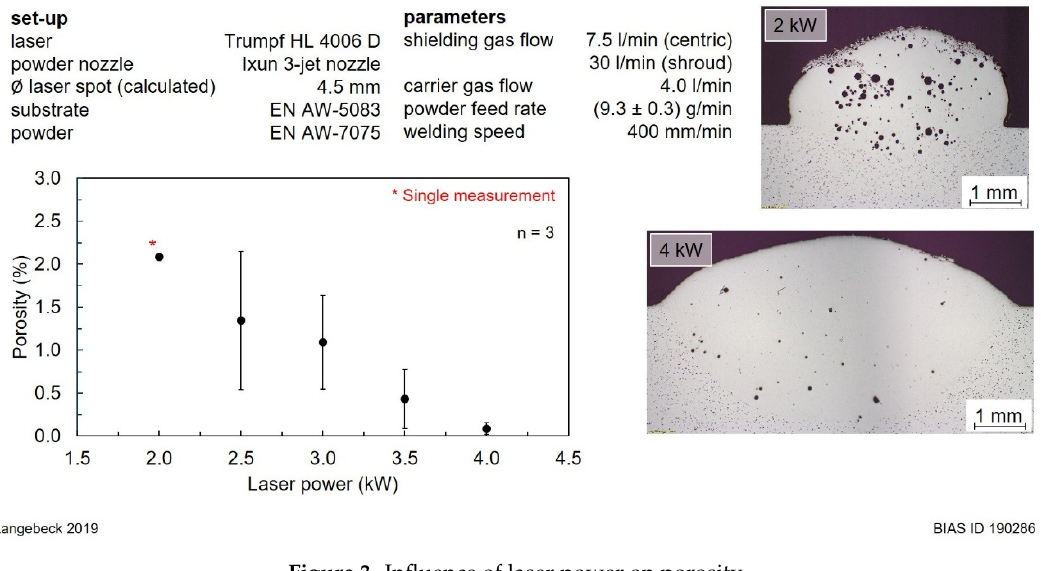
Figure 3. Influence of laser power on porosity.